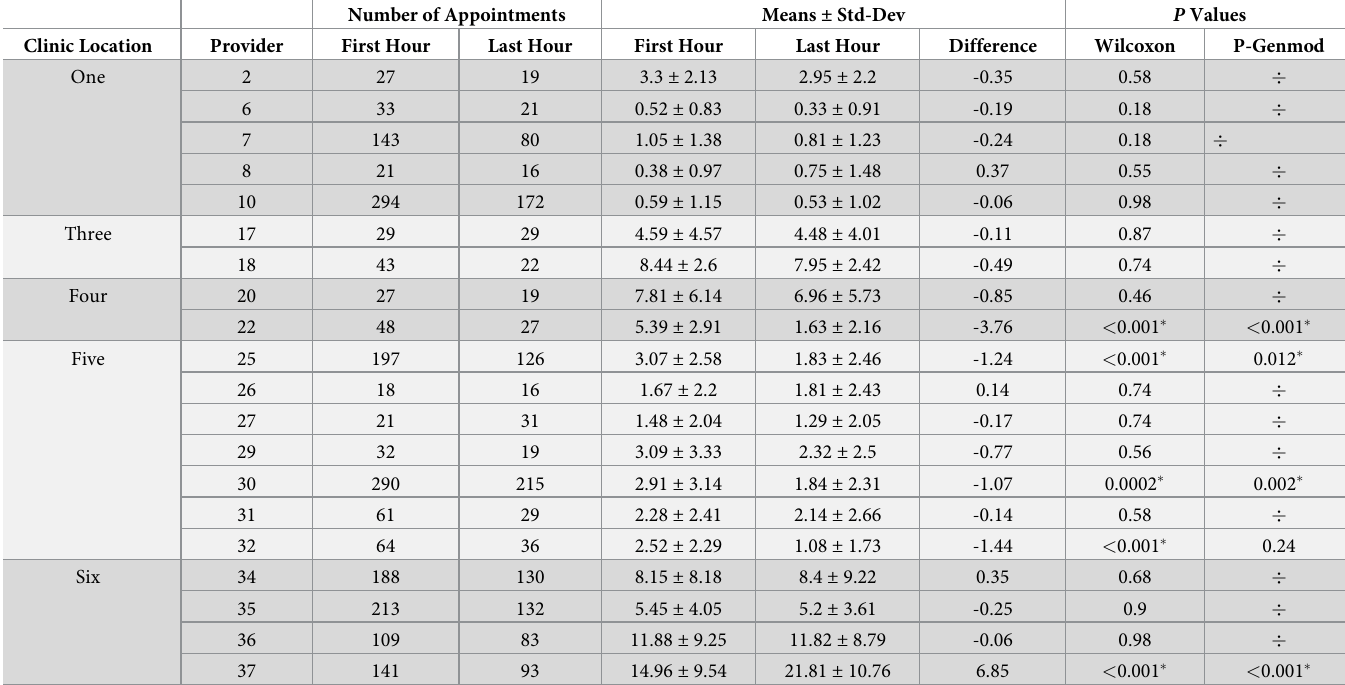
Table 2. Differences in mean number of laboratory tests